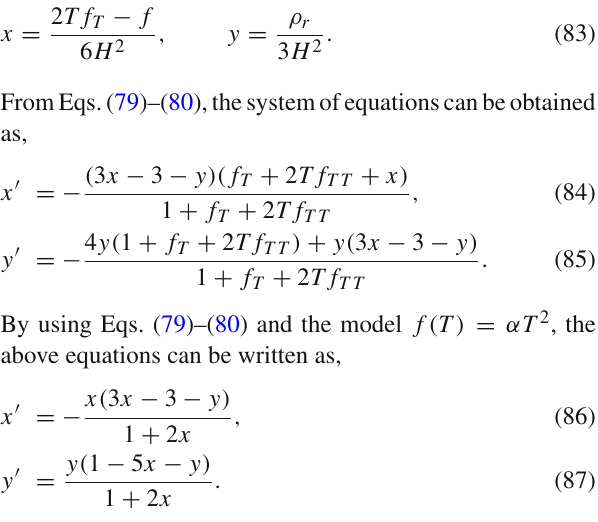
accelerating. For critical point L , one eigenvalue β 1 is pos- itive and another eigenvalue β 2 is negative. So, the critical point L is unstable point due to the presence of positive and negative eigenvalues. For the critical point L , the density parameters (cid:3) m = (cid:3) de 0, (cid:3) r = 1 represents that the Uni- verse is in radiation dominant phase and the corresponding EoS parameter ω ef f = 1, deceleration parameter q = 1 shows that the expansion of the Universe is